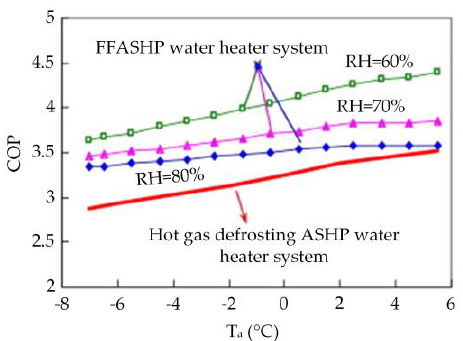
Figure 27. Comparison of COP between the FFASHP water heater and the hot-gas defrosting ASHP water heater [83].